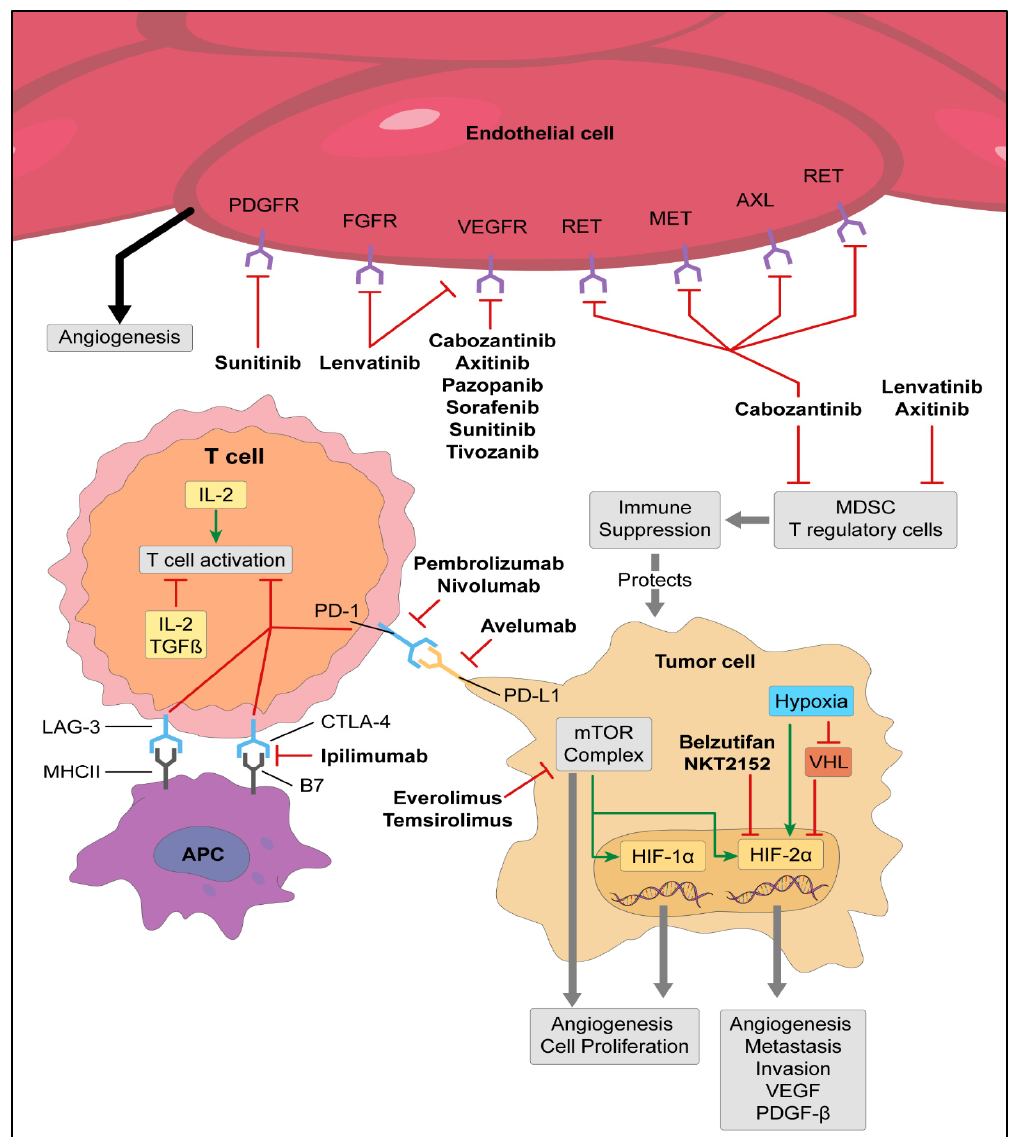
Figure 2. Mechanisms of action for agents used in renal cell carcinoma.